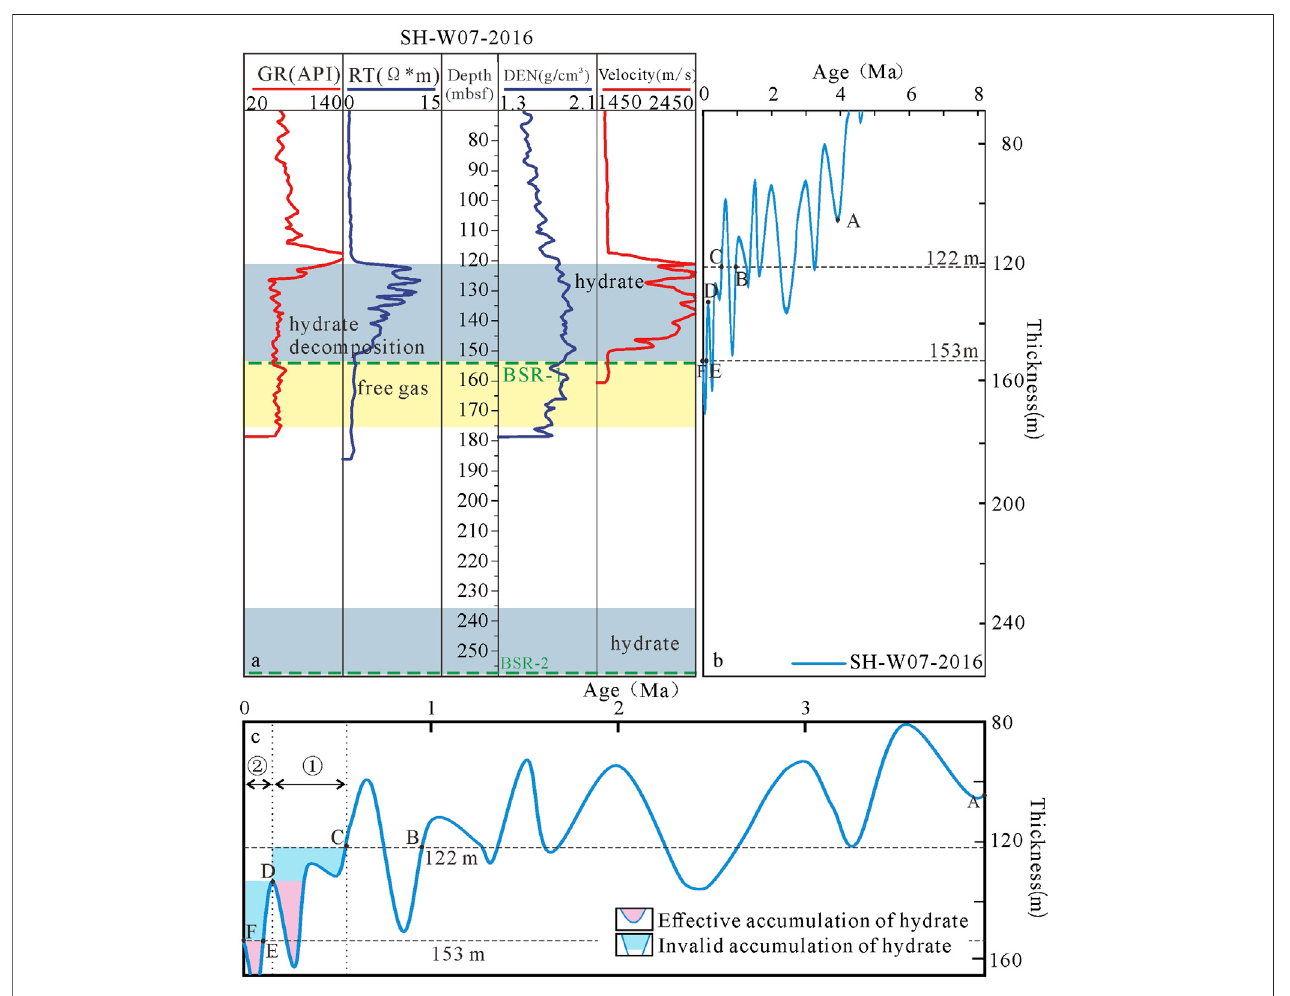
FIGURE 9 | (A) The LWD response characteristics of site SH-W07-2016 between 70 mbsf and 260 mbsf (data source: Zhang et al., 2020b). (B) The thickness evolution of the GHSZ at site SH-W07-2016 since 8.2 Ma. (C) The thickness evolution of the GHSZ at site SH-W07-2016 since 4 Ma (blue/pink parts in the fi gure correspond to the possible formation/decomposition times of decomposed hydrate at 132 – 137 m and 146 – 151 m).